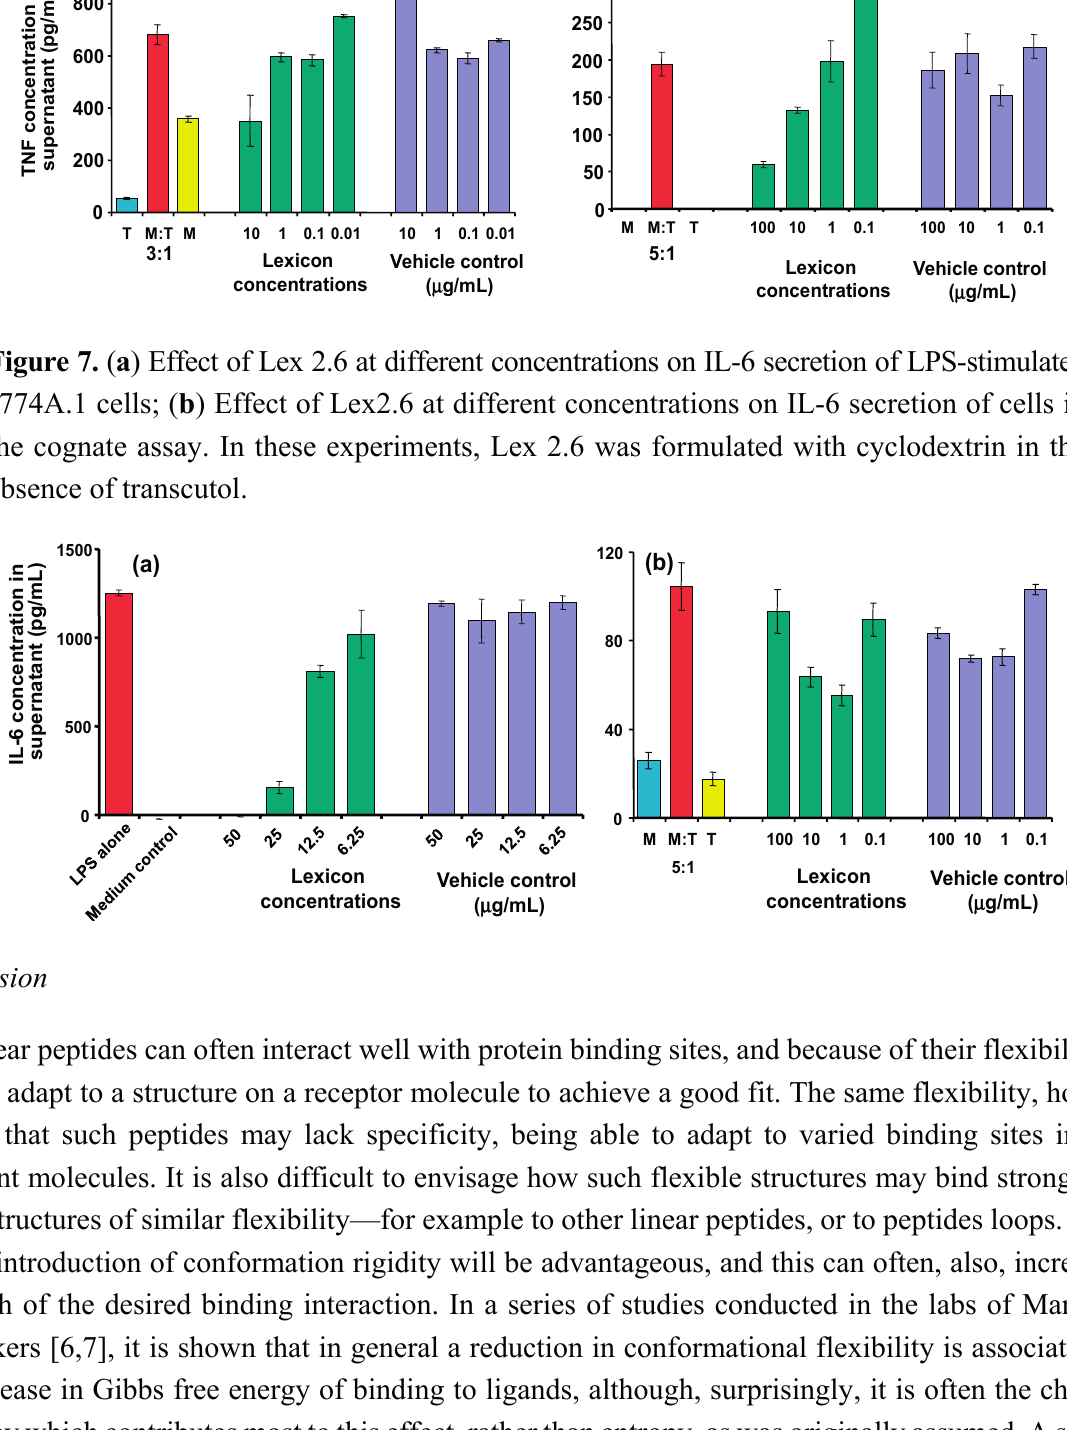
( b ) Lex 2.6 formulated with cyclodextrin in absence of transcutol.